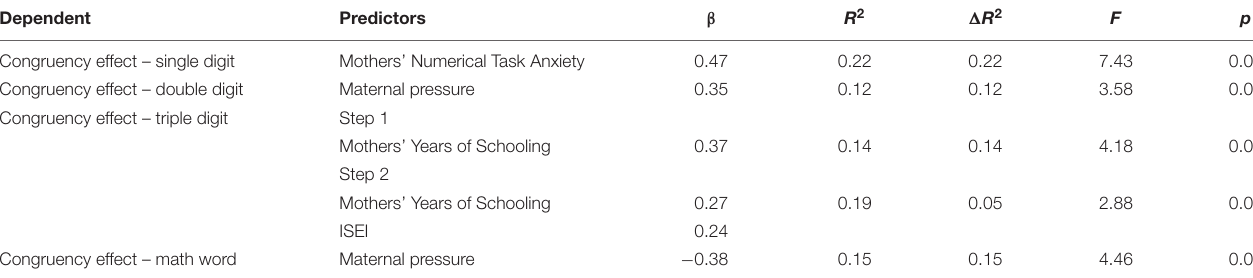
TABLE 5 | Summary of the hierarchical regression analyses to predict children’s implicitly measured math anxiety (i.e., by the numerical dot-probe task). Dependent